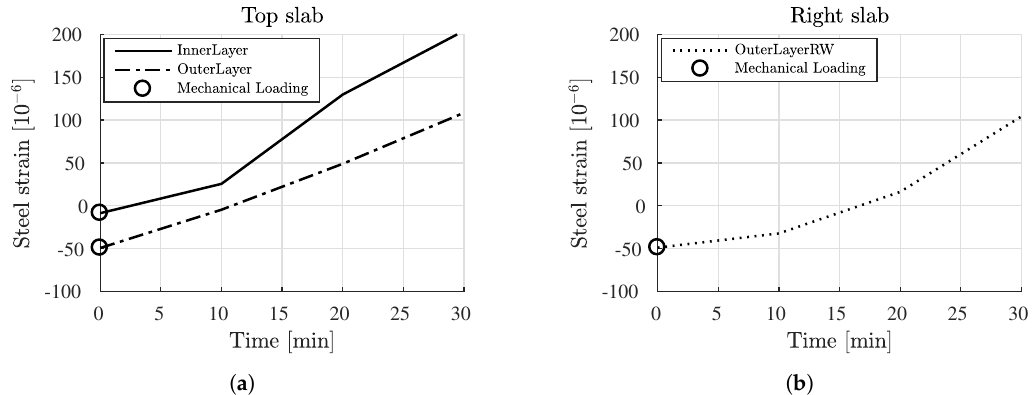
Figure 9. Measured evolutions of total strains of steel rebar: ( a ) top slab, at the midspan of the left cell, and ( b ) center of the right wall.